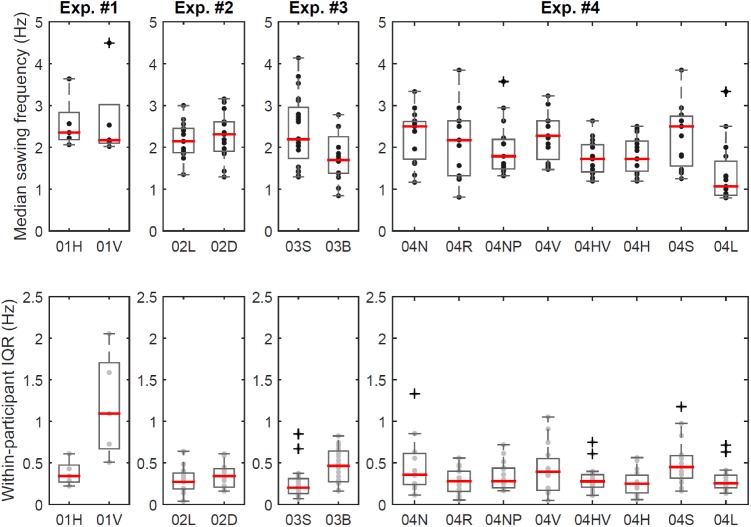
Results for experiment #1 to #4.Boxplots of participant-specific median in sawing frequency (top) and within-participant variation (bottom) for each experiment and each condition within the experiment. Black/grey dots: individual data points. Black/grey dots: individual data points. Experiment #1: 01H - horizontal sawing, 01V - vertical sawing; experiment #2: 02L - line sawing, 02D - disc sawing; experiment #3: 03S - small saw, 03B - large (big) saw; experiment #4: 04N - normal sawing, 04R –repeat of normal sawing at end of session, 04NP–sawing with non-preferred hand, 04V - vertical sawing, 04HV—vertical sawing with heavy saw, 04H - sawing with heavy saw, 04S - sawing with short blade length, 04L –sawing with long blade length.